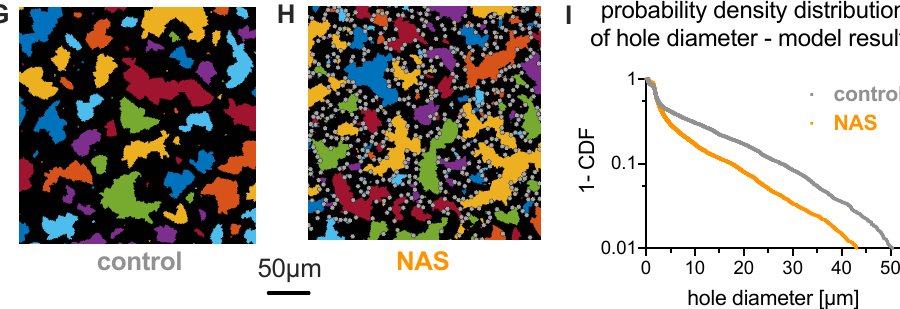
Figure 3. Characteristics of sedimenting erythrocyte aggregates in autologous plasma. ( A , B ): Sedimented layer of erythrocytes in plasma for a control subject and a patient on the bottom of a microscopy chamber after 2 h. Pictures were taken from the bottom of the well. ( A ): Healthy control donor and ( B ): patient (MLS-3). The volume fraction (hematocrit) in the microscope slide well (inner diameter 5 mm, height 1.5 mm) was initially 0.33% to reach a volume fraction close to 45% at the bottom of the well after sedimentation. ( C , D ): The same pictures as the previous, but with the holes detected in the percolating network of erythrocytes highlighted with random colors. The 50 µ m scale is valid for panels ( A ) to ( D ). ( E ): Example of distributions of the square root of the hole areas, or hole diameter, shown as complementary cumulative density functions. The linear curve reflects an exponential distribution with the mean hole diameter as a single scale parameter. This scale parameter was estimated by the maximum likelihood method. ( F ): Statistical comparison of the scale parameters for control and neuroanthocytosis syndrome (NAS) erythrocytes in autologous plasma. The scale parameters are normally distributed among each population, and a t -test between the two populations indicates a significant difference ( p = 0.005, implying a significance level **, i.e. p < 0.01). ( G ): Simulation snapshot of healthy conditions with 100% discoid erythrocytes shown in black color, similarly to experimental images. ( H ): Simulated aggregate of a mixture of 80% normal erythrocytes (black area) and 20% acanthocytes (gray color) by area fraction. The scale bar is valid for panels ( G ) and ( H ). ( I ): Complementary cumulative density function of the square root of the hole areas from the simulations of healthy erythrocytes and the erythrocyte–acanthocyte mixture exemplified in ( G ) and ( H